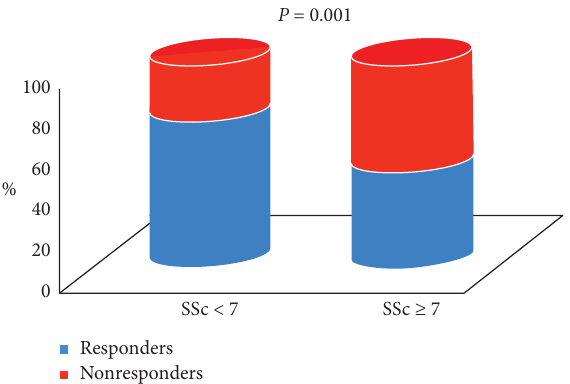
Figure 2: Distribution of responders and nonresponders according to the median value of the Selvester score.